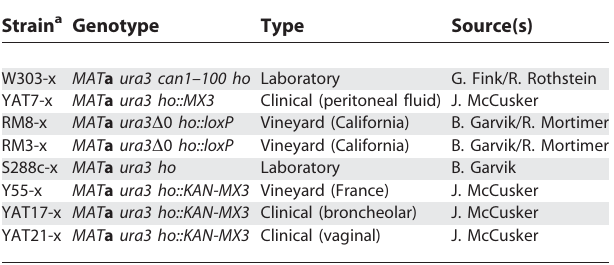
Table 1. Strains Used in This Study Strain a Genotype